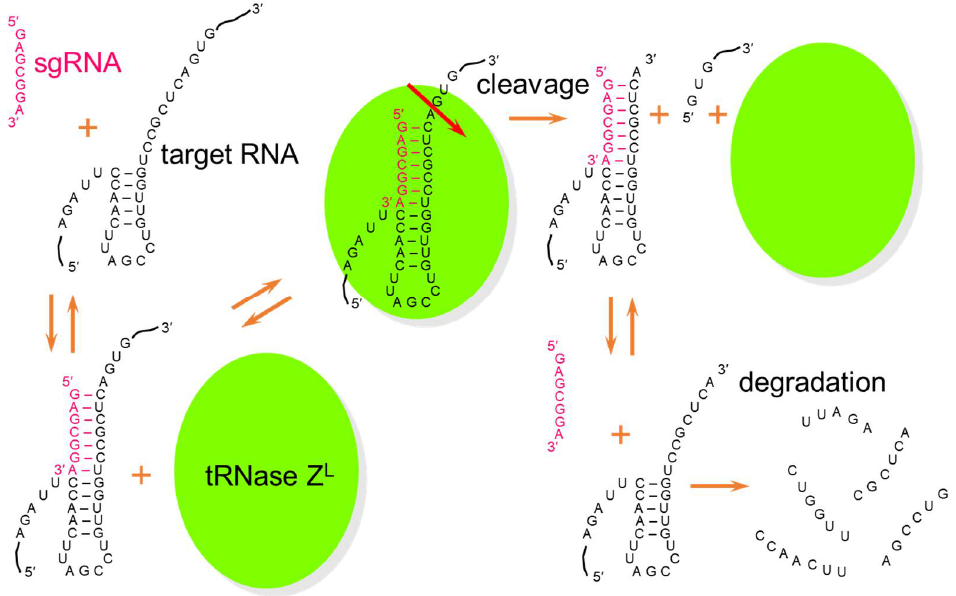
Figure 2. Molecular mechanism of TRUE gene silencing. A heptamer-type sgRNA binds a target RNA immediately after a 5-base-pair T-arm-like structure to form an sgRNA/target RNA complex. tRNase Z L recognizes this RNA complex and cleaves target RNA after a nucleotide corresponding the discriminator. The cleaved RNAs are further degraded by other nucleases, and the sgRNA and tRNase Z L can be reused to cleave another target RNA. Table 1. Application of TRUE gene silencing to human cancer cells in order to induce apoptosis.